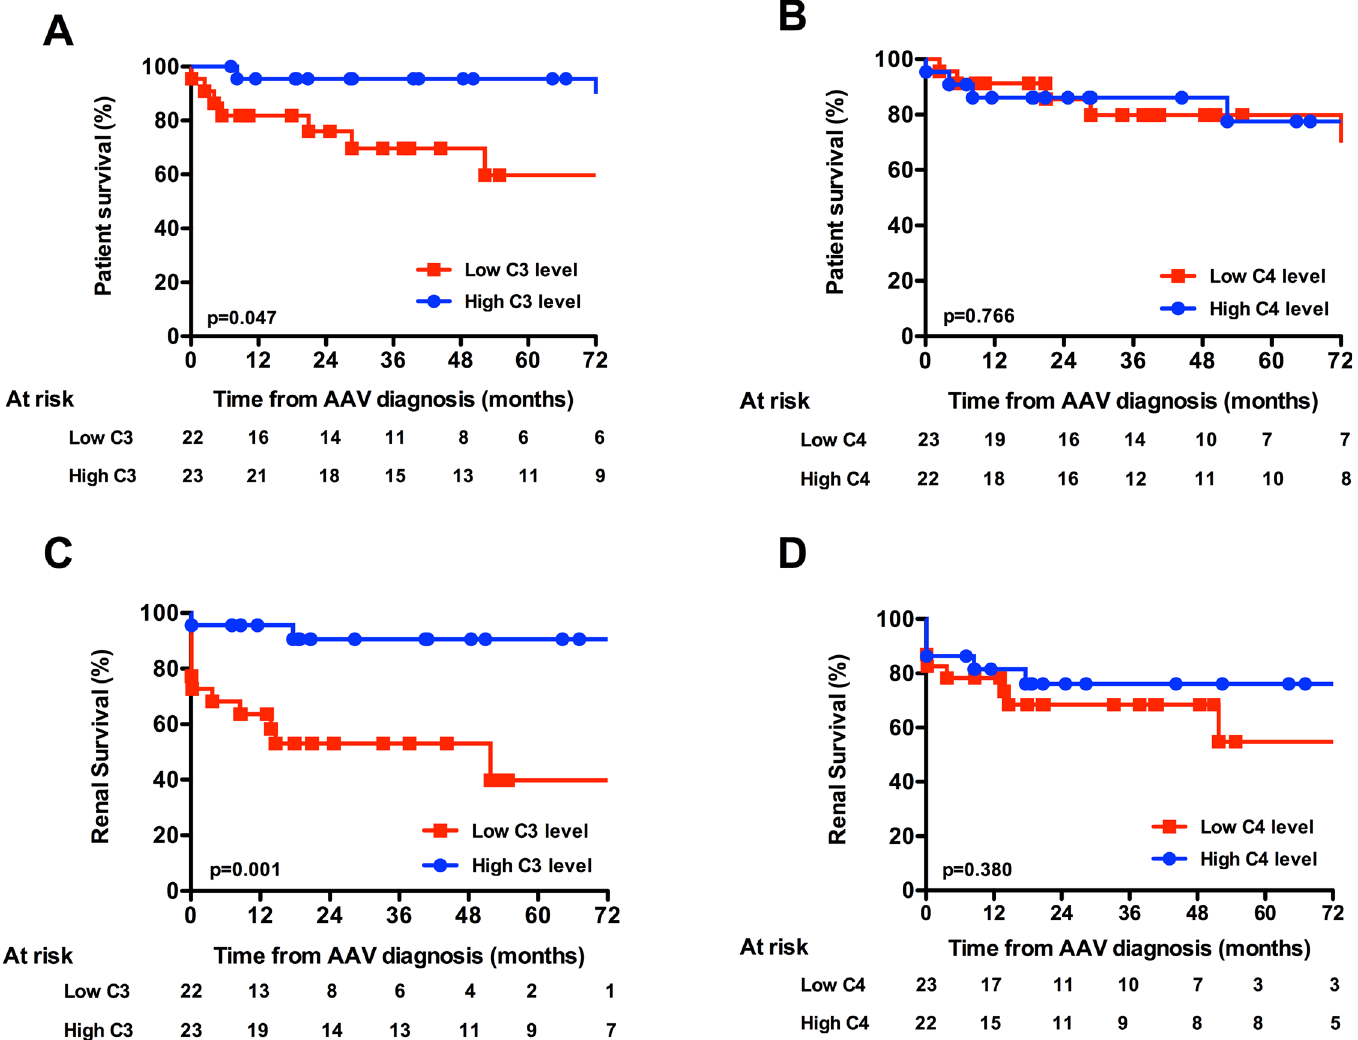
Fig 1. Patient and death-censored renal survivals according to C3 and C4 levels. (A) Patient survival according to C3 level and (B) C4 level. (C) Death- censored renal survival according to C3 lavel and (D) C4 level.